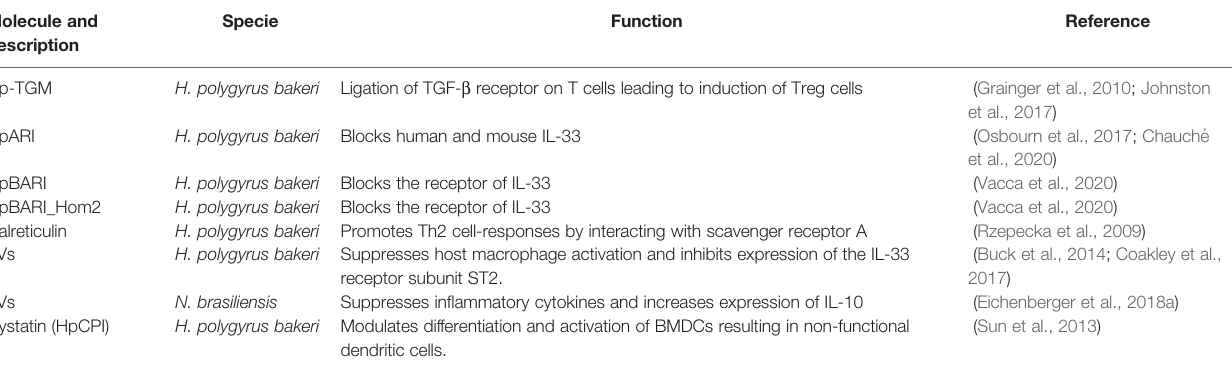
TABLE 1 | Immunomodulatory molecules expressed in the hookworm models Heligmosomoides polygyrus bakeri and Nippostrongylus brasiliensis . Molecule and